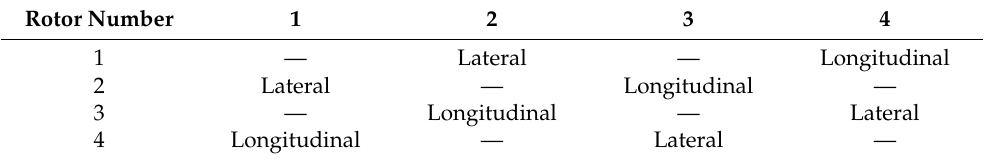
Table 2. Categories of rotor–rotor interaction. Rotor